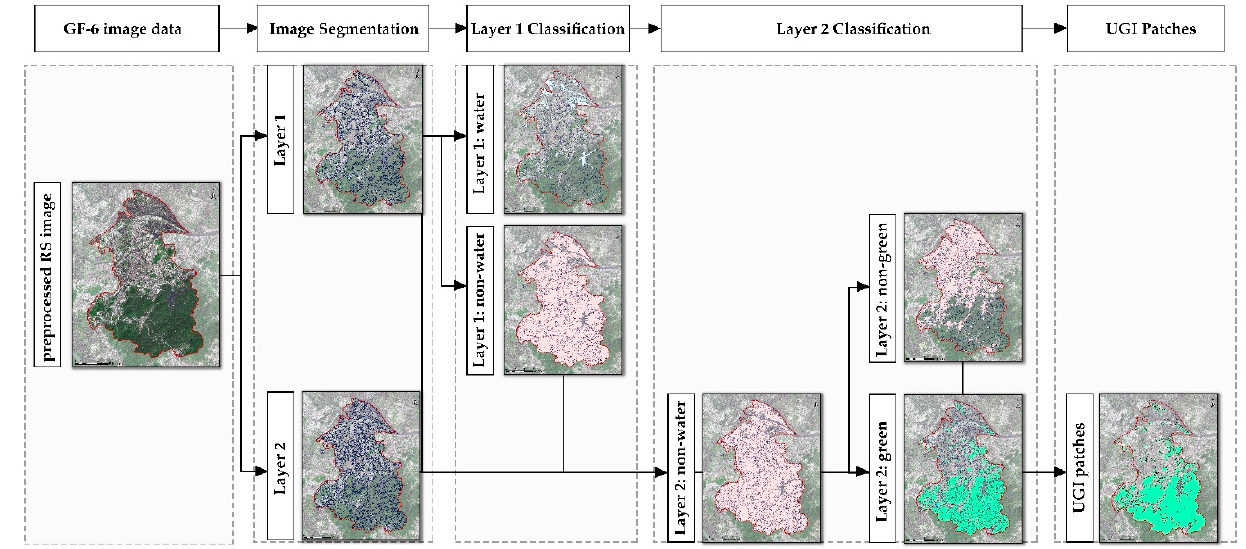
Figure 4. Flowchart of UGI interpretation.